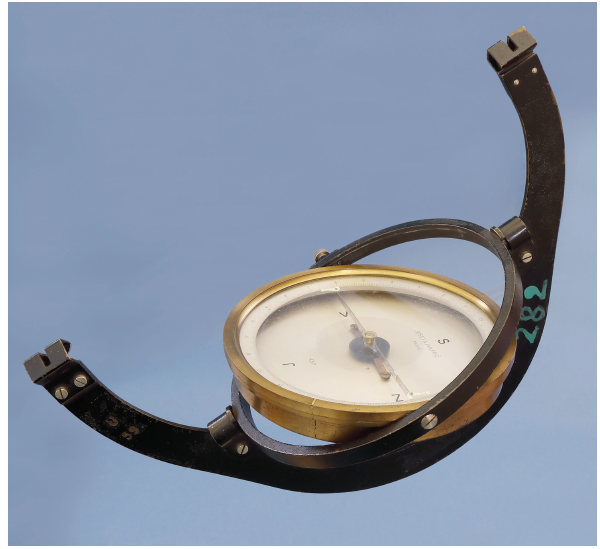
Figure 5. Hanging compass by J. & J. Friˇc company (photo sup- plied by